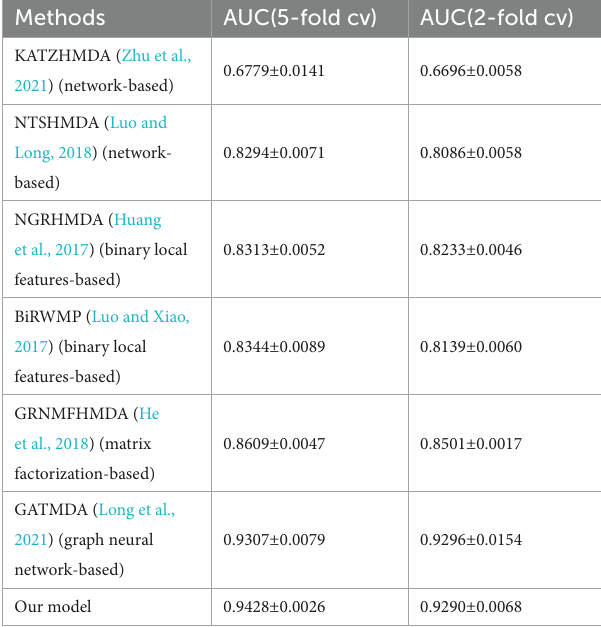
TABLE 2 Comparison performance between our model and state-of-the- art models based on Disbiome dataset.